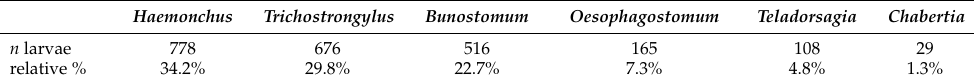
Table 2. Number and relative percentage of third-stage larvae of the different genera of GIS identified in the whole study area ( n = 2272). Larvae ascribable to Strongyloides are not considered here. Haemonchus Trichostrongylus Bunostomum 778